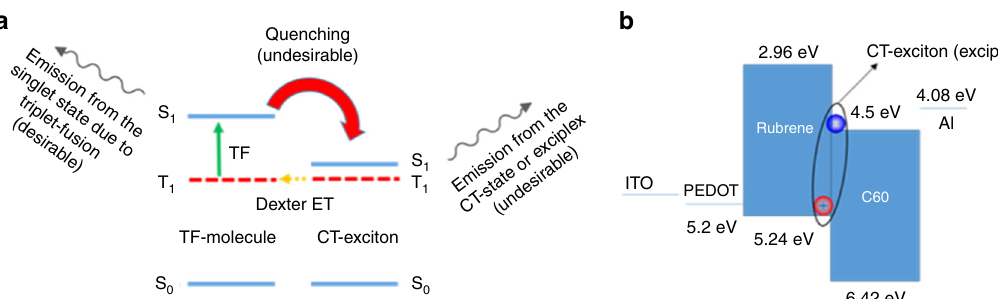
Fig. 1 Working mechanism of CT-assisted OLEDs. a Energy transfer schematic and mechanism of previously reported OLEDs with EL at sub-bandgap voltages. b Energy level diagram of rubrene and C 60 based